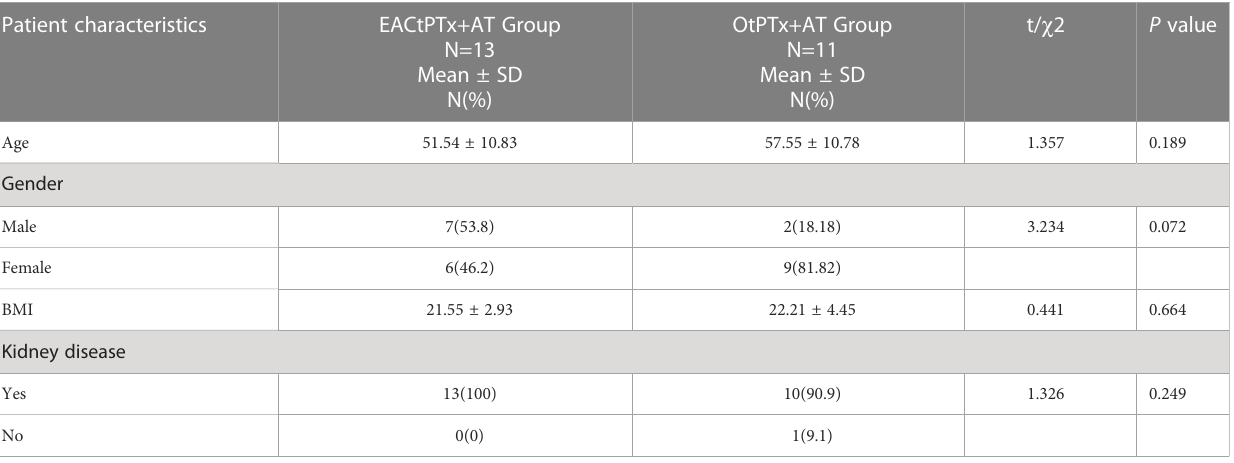
TABLE 1 Comparison of Clinical Data